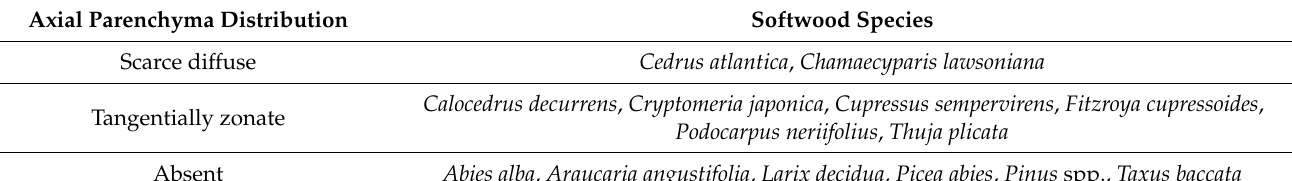
Figure 7. Axial parenchyma distribution in softwoods (transverse sections). ( A ) scarce diffuse ( Chamaecyparis lawsoniana ); ( B ) tangentially zonate ( Cryptomeria japonica ); ( C ) absent ( Araucaria angustifolia ). Table 9. Examples of species for different types of axial parenchyma distribution in softwoods.